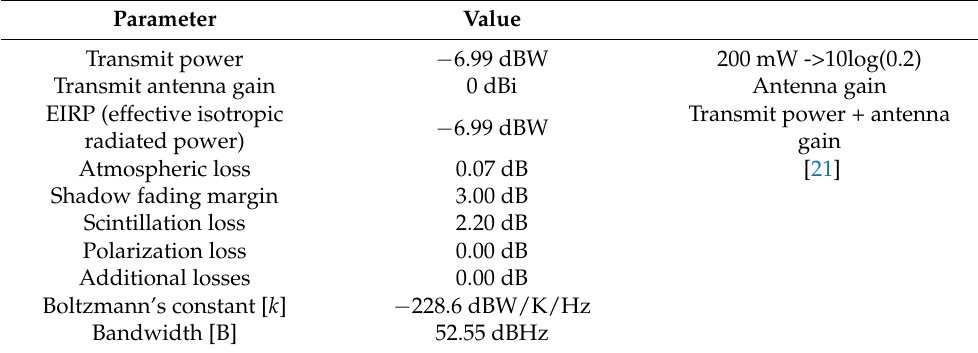
Table 6. Link budget simulation parameters.